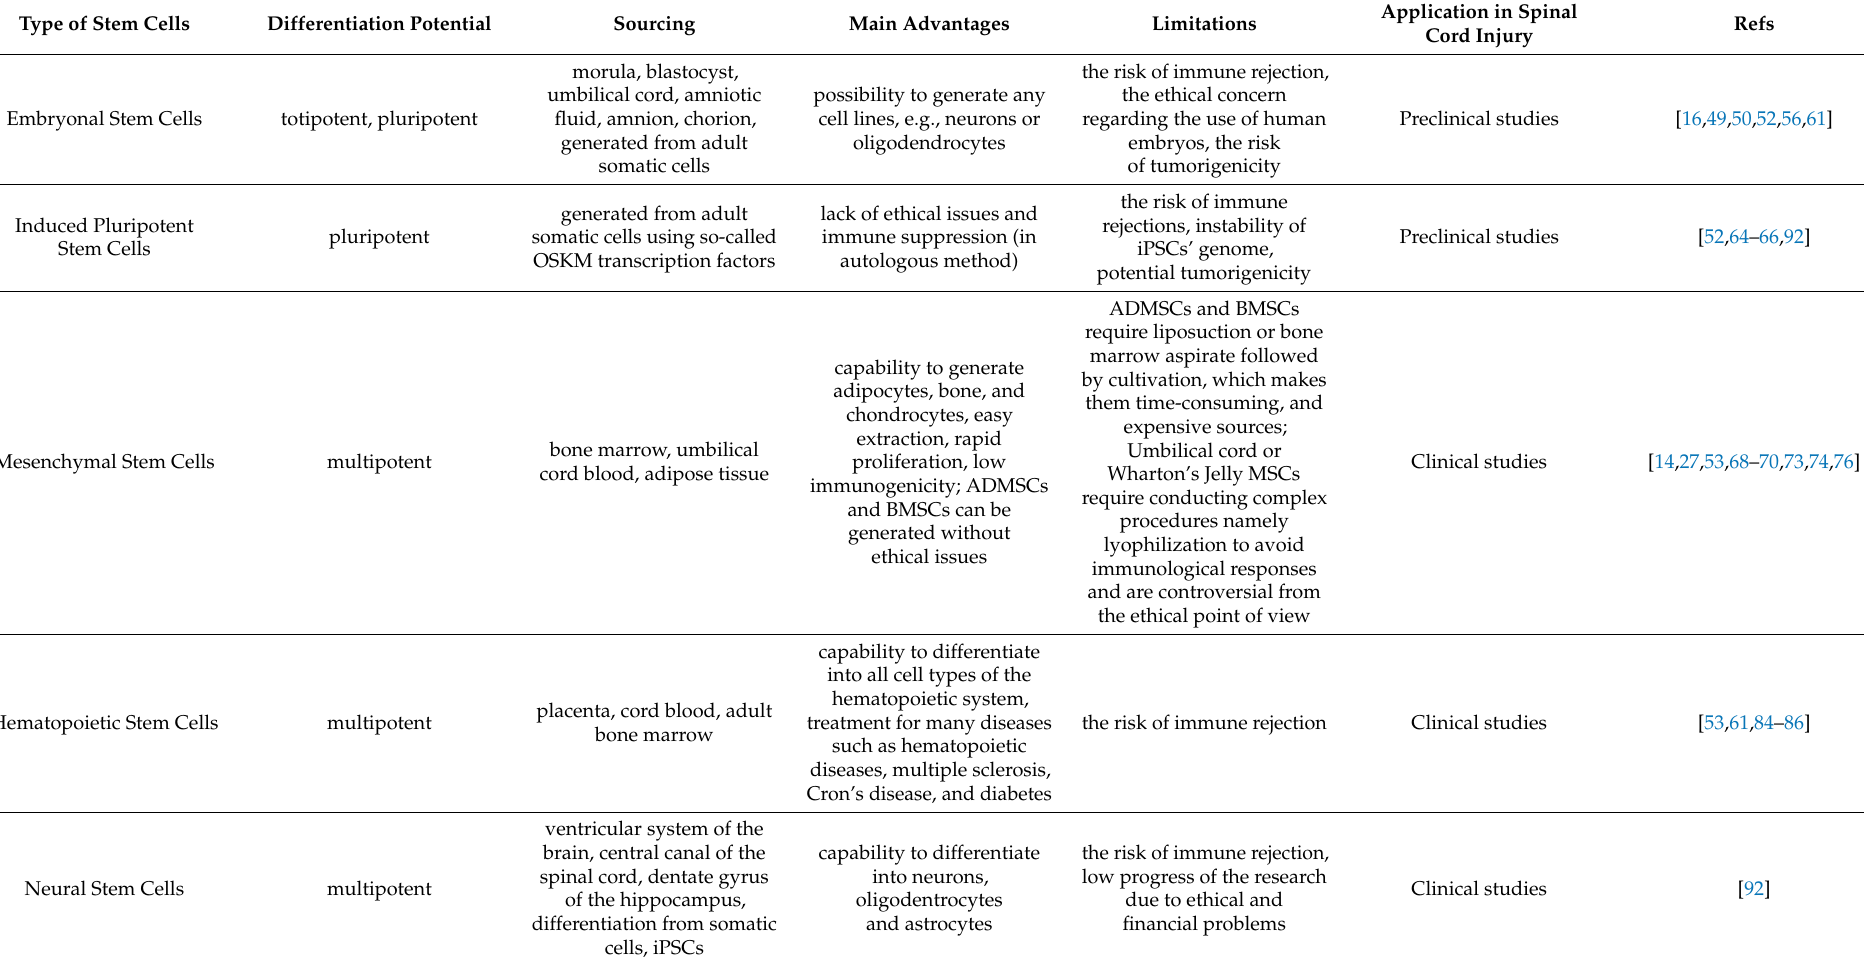
Table 1. Main characteristics of various stem cell types investigated for application in Spinal Cord Injury